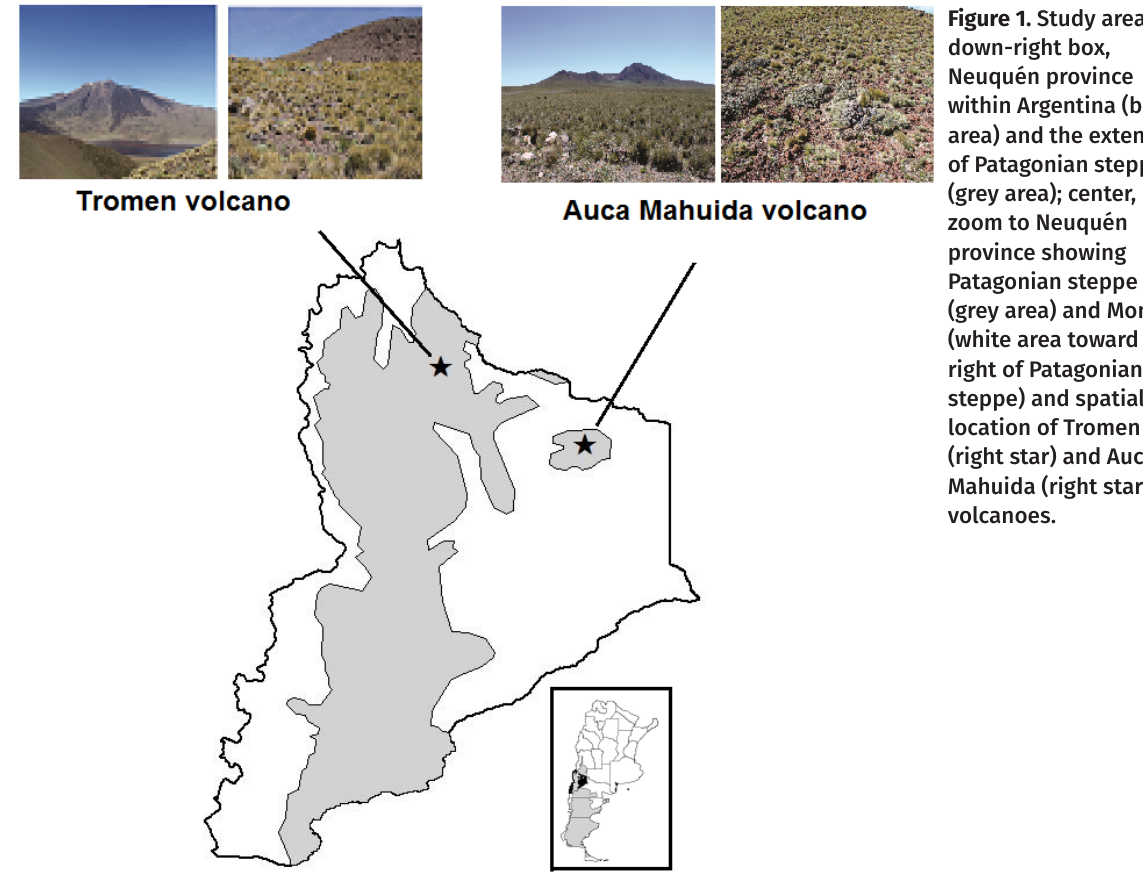
Figure 1. Study area: down-right box, Neuquén province within Argentina (black area) and the extension of Patagonian steppe (grey area); center, zoom to Neuquén province showing Patagonian steppe (grey area) and Monte (white area toward the right of Patagonian steppe) and spatial location of Tromen (right star) and Auca Mahuida (right star)